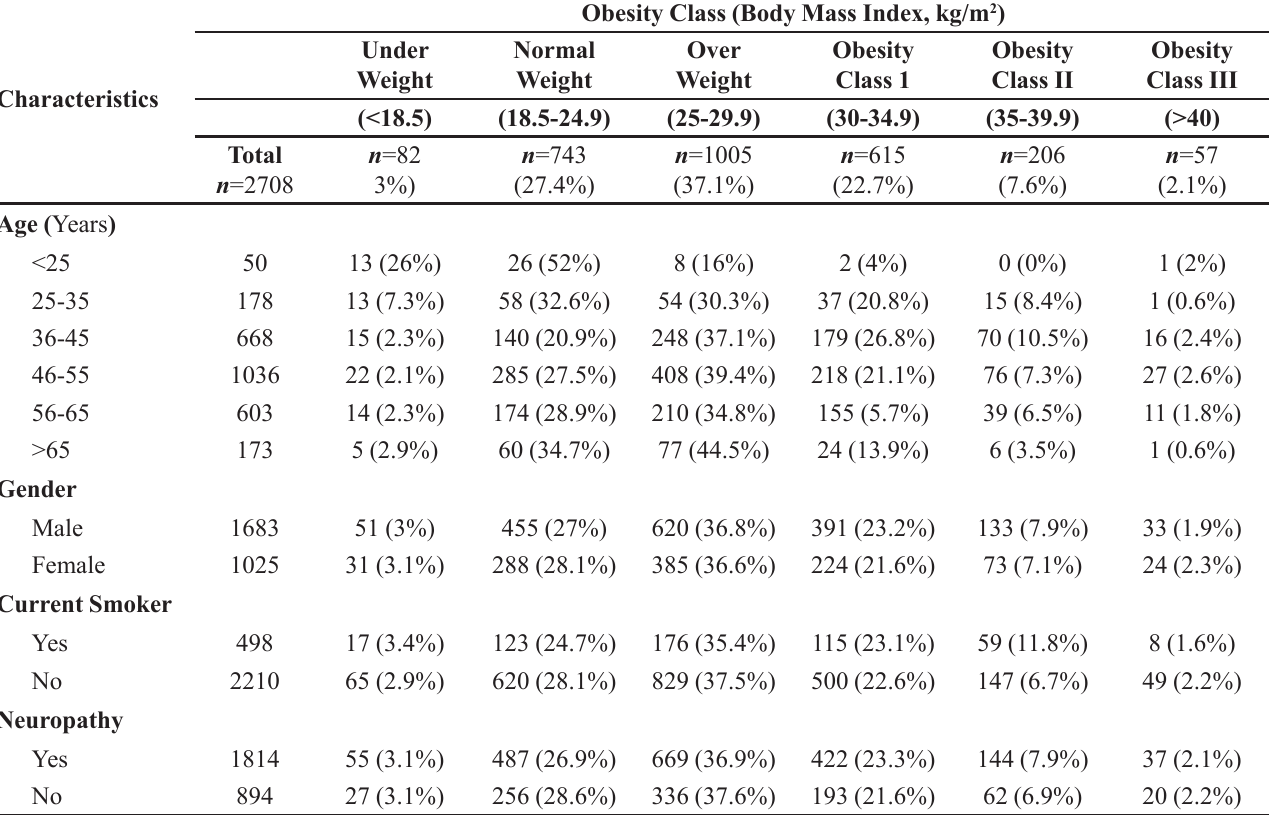
TABLE I - Patient’s basic demographics